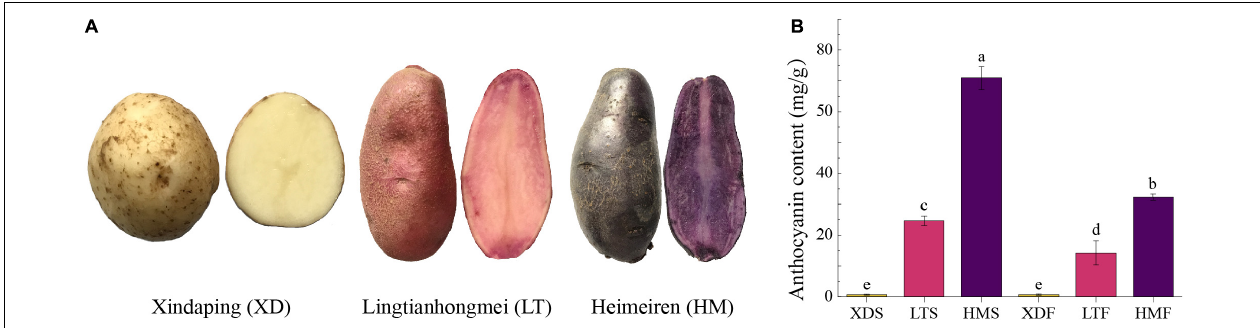
FIGURE 1 | Phenotypes of three potato cultivars in (A) “Xindaping” (XD—white skin and white flesh), “Lingtianhongmei” (LT—red skin and red flesh), and “Heimeiren” (HM—purple skin and purple flesh). (B) The content of anthocyanin in three potato cultivars. Data represent the mean of three biological replicates ± standard error. Standard errors are shown as bars above the columns. Different letters above bars denote significant difference at P < 0.05.